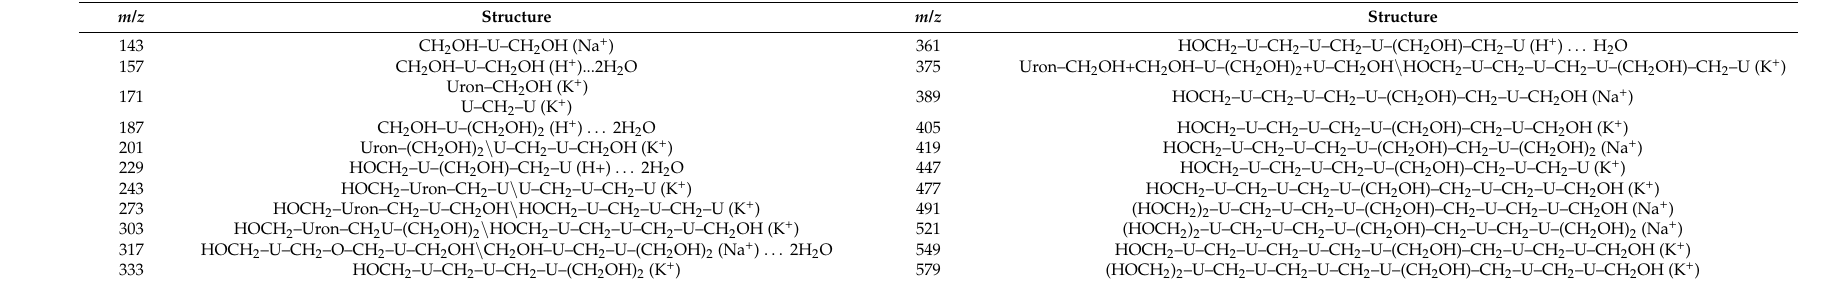
Table 3. Assignment for the ESI–MS peaks of the UF reaction products at the acidic stage (Sample